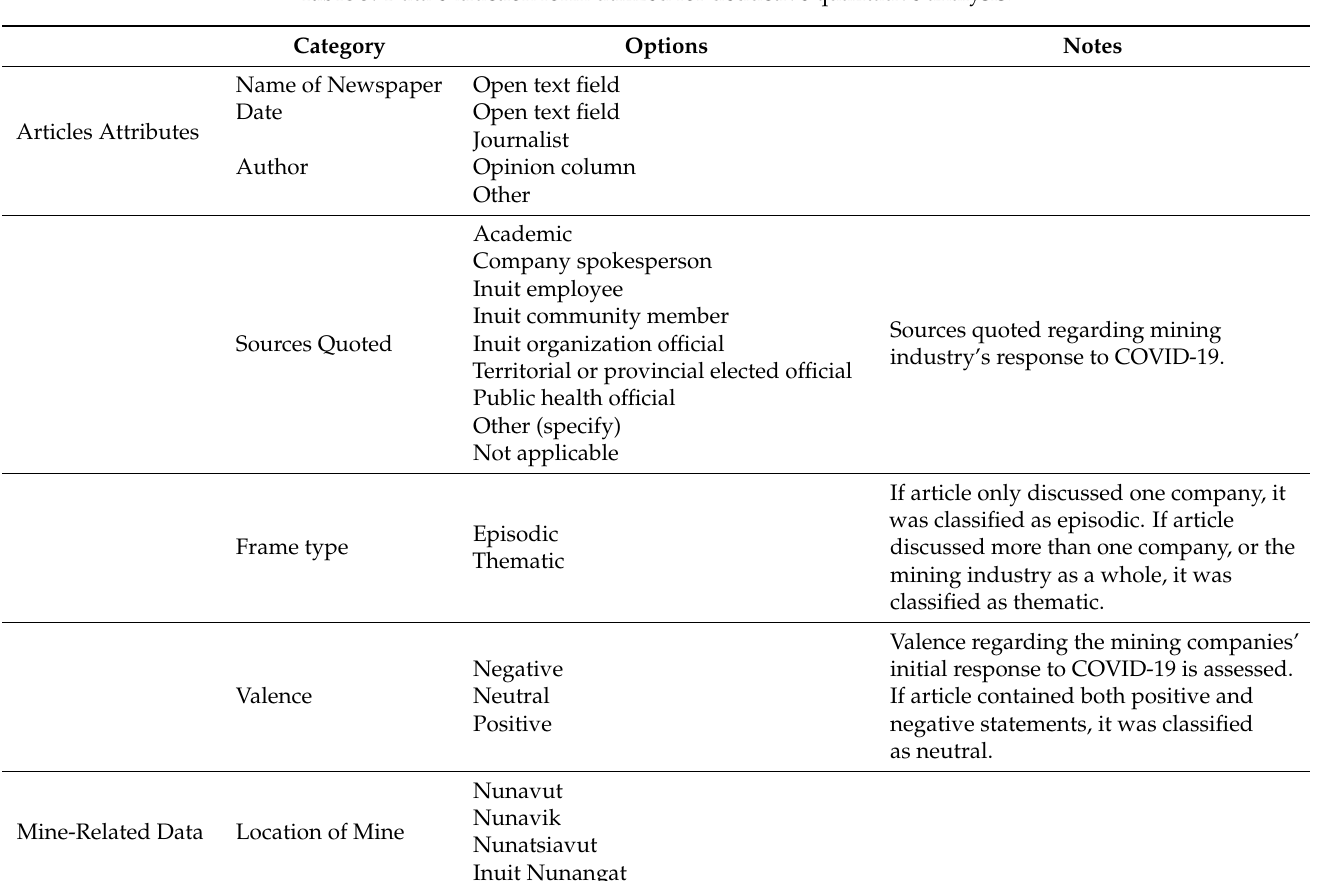
Table 3. Data extraction form utilized for deductive qualitative